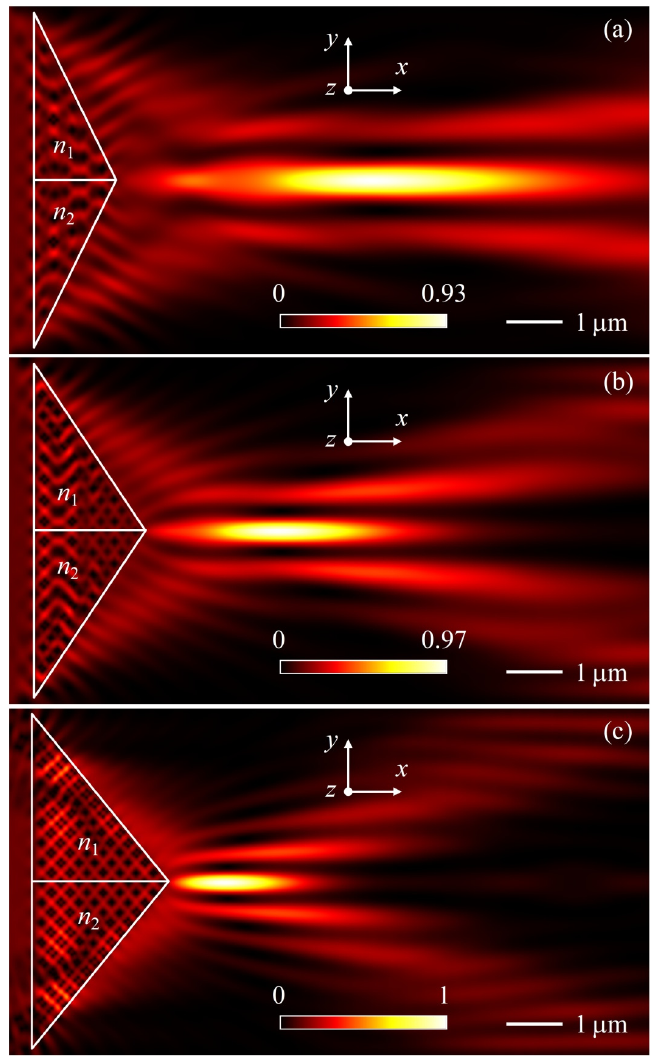
Figure 2. Normalized intensity distributions of the photonic nanojets formed by conventional triangular micro-prisms at ( a ) h = 1.5 μ m, ( b ) h = 2 μ m, and ( c ) h = 2.5 μ m. The refractive index of triangular micro-prisms is n 1 = n 2 = 1.5.